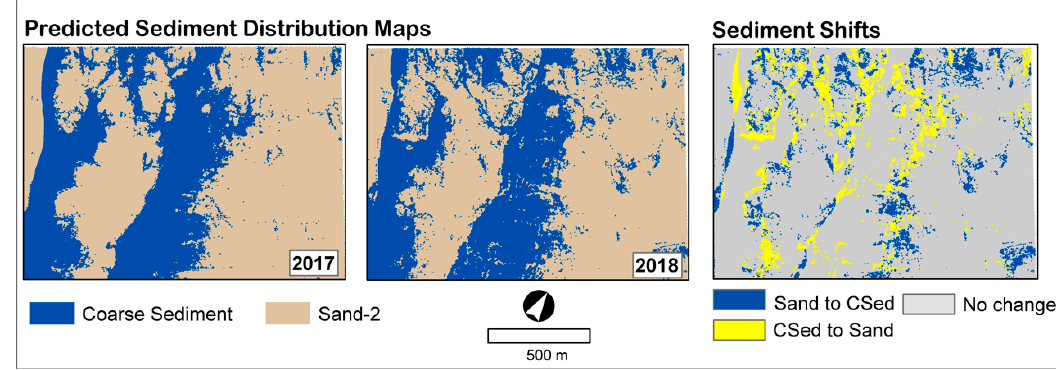
Figure 8. Predicted sediment distribution maps and the detected sediment shifts in H5 between 2017 and 2018 (four months apart).